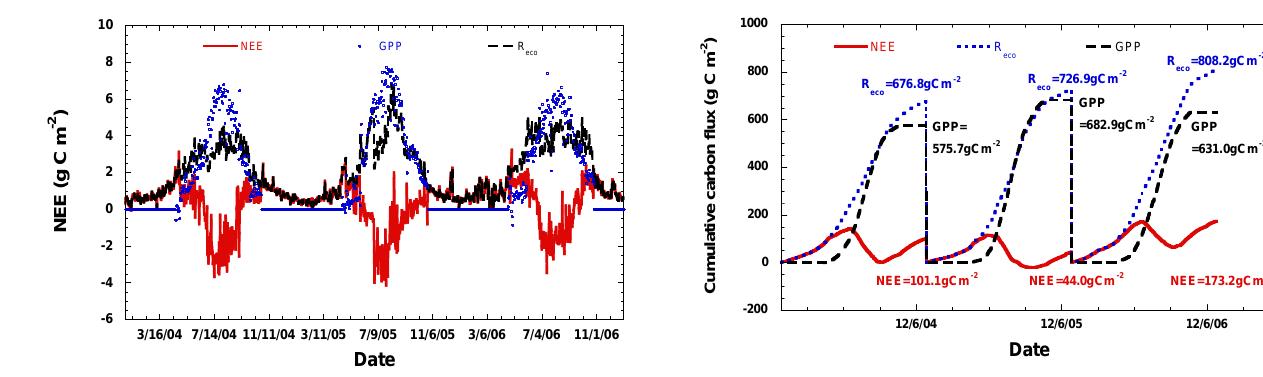
Fig. 10. Seasonal pattern of daily total gross primary production ( GPP ) , net ecosystem exchange ( NEE ) , and ecosystem respiration ( R eco ) over the course of the alpine wetland meadow from 1 January 2004 to the end of the year 2006.